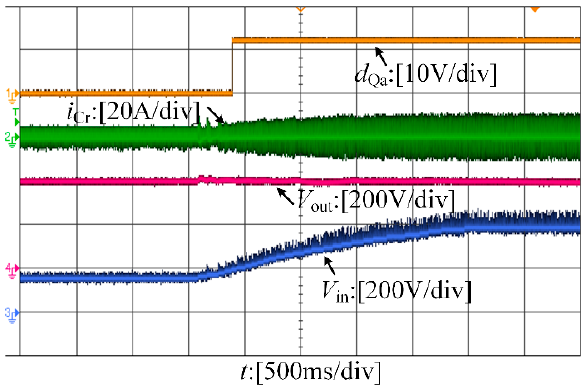
Figure 20. Experimental waveforms of mode transition.